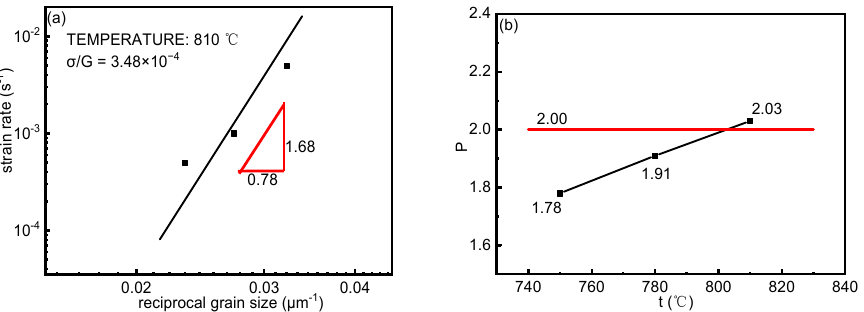
Figure 6. ( a ) The variation in strain rate as a function of reciprocal grain size in Ti-6Al-4V alloy, ( b ) grain size vs. temperature curve of Ti-6Al-4V alloy.